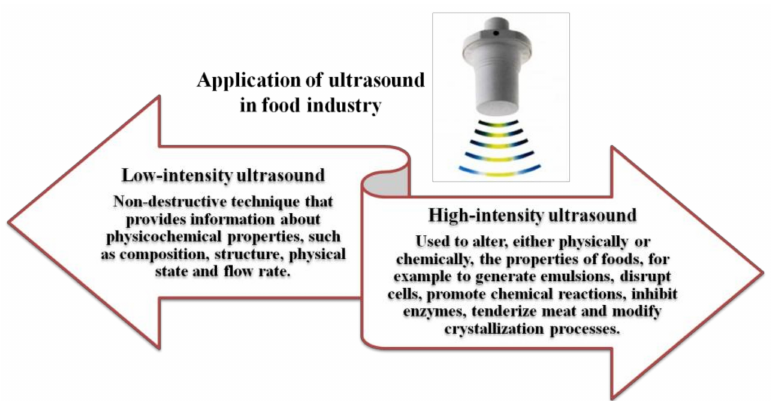
Figure 2. Applications of ultrasound in food analysis and